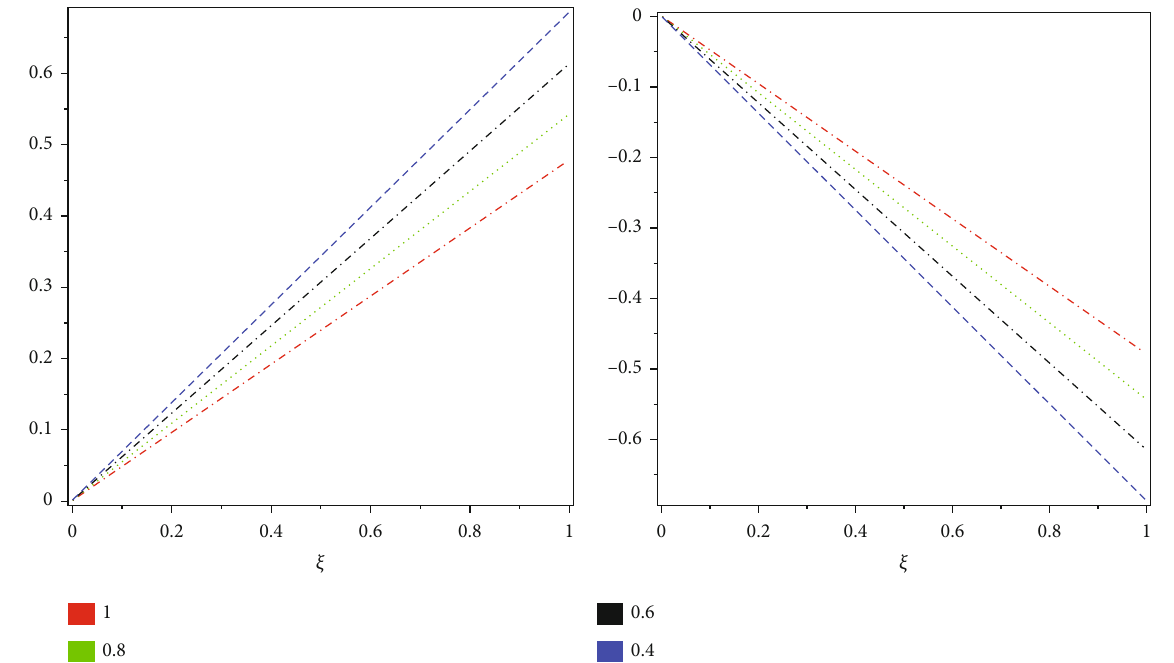
Figure 1: First two-dimensional fuzzy upper branch graph and second bottom branch graph of an analytic series result of various fractional of ρ .